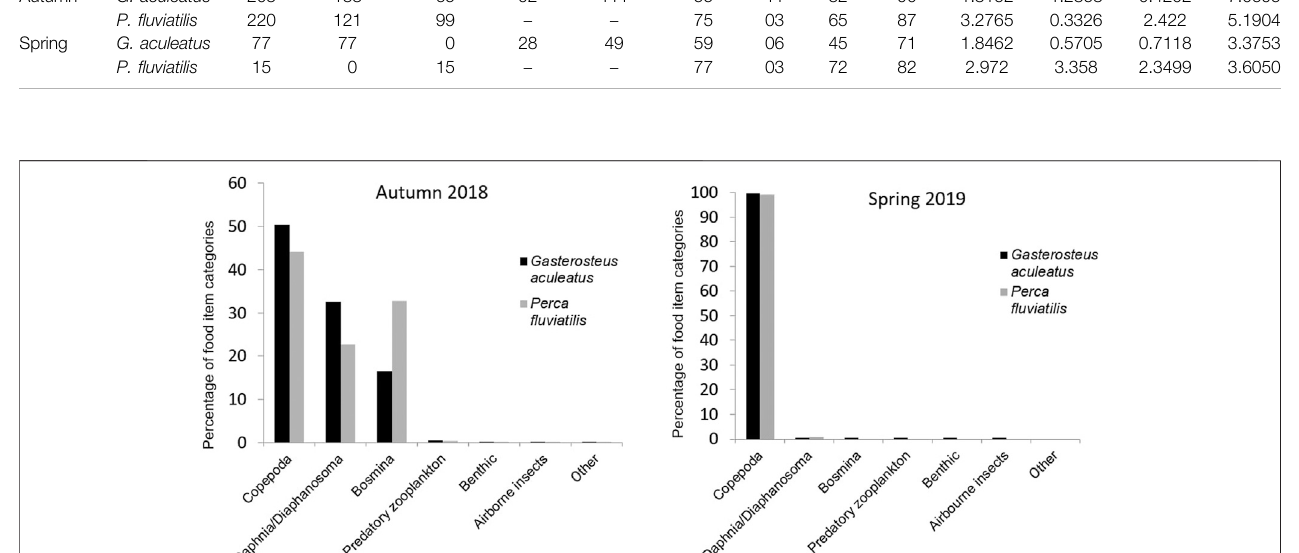
FIGURE 1 | Prey composition based on food item numbers in stomachs of investigated stickleback and perch from Lake Constance in autumn 2018 and spring 2019.